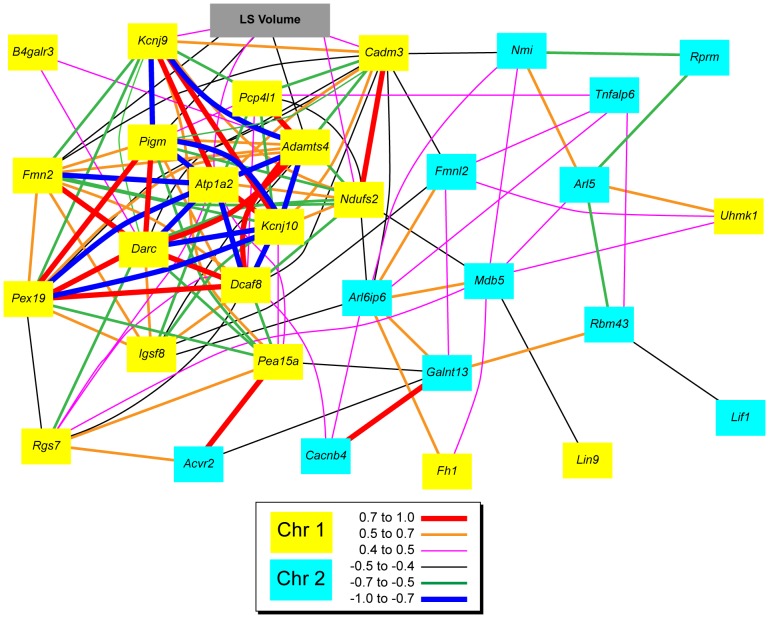
Covariation of LS volume (gray) with Chr 1 (yellow) and Chr 2 (blue) candidate gene expression in the hippocampus.Legend indicates the strength of the correlation between the genes.